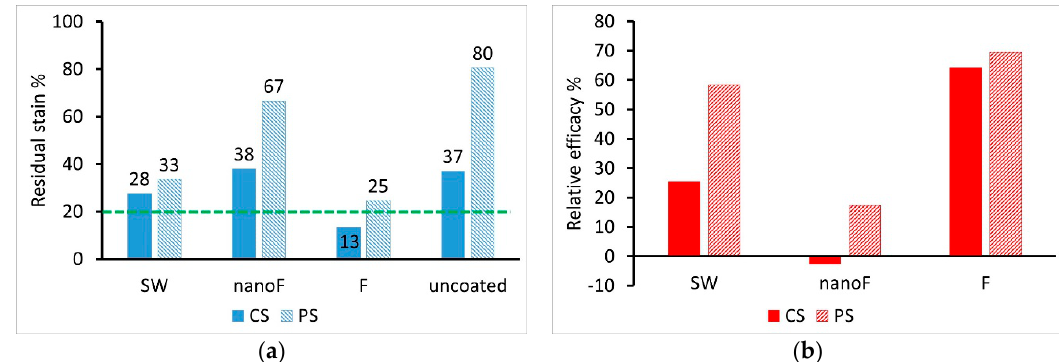
Figure 9. Evaluation of the spray paint removal: ( a ) residual stain, as defined in Equation (2), with the green line indicating the acceptable threshold; ( b ) relative efficacy, as defined in Equation (3).